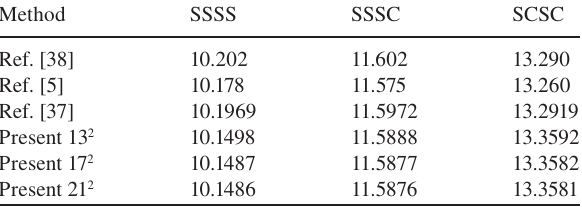
Table 2 Bi-axial buckling load of three-layer [0/90/0]